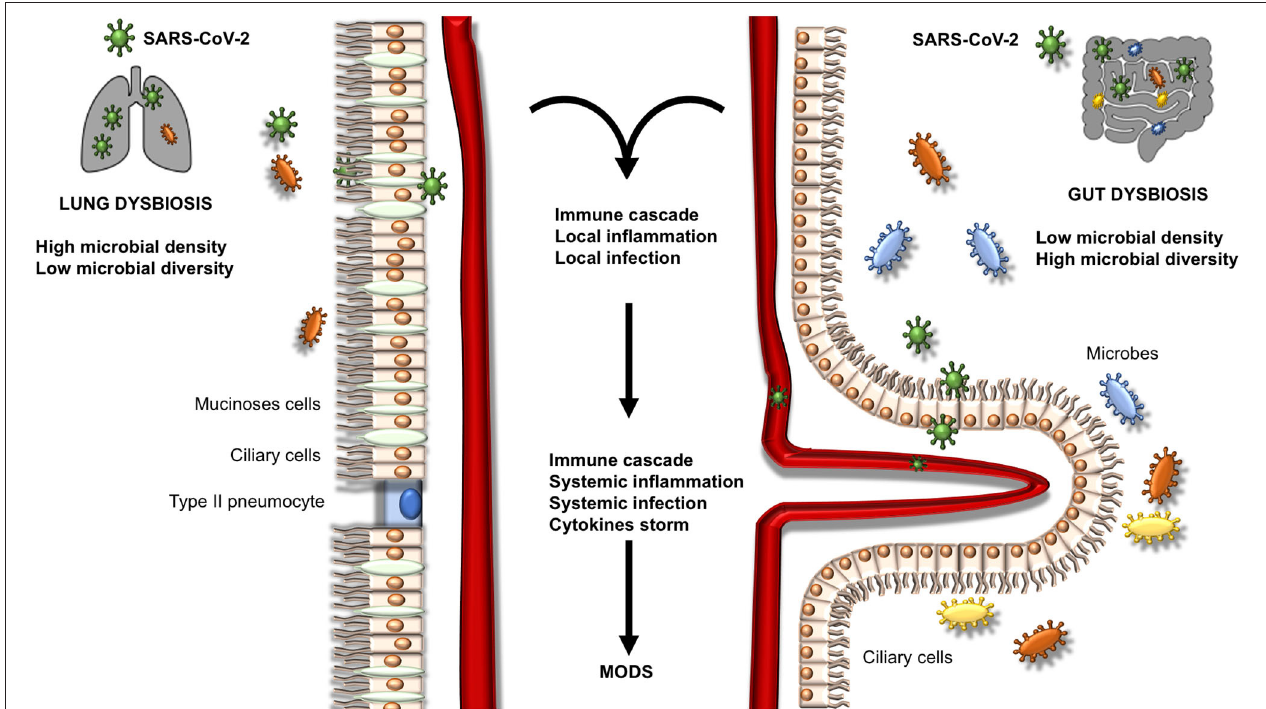
FIGURE 1 | Mechanisms of microbiota gut-lung axis dysbiosis. This figure represents the possible evolution of dysbiosis in the lungs and intestine. A local inflammatory process is activated, thus converting in a systemic inflammatory process with possible infection and multiorgan disease syndrome